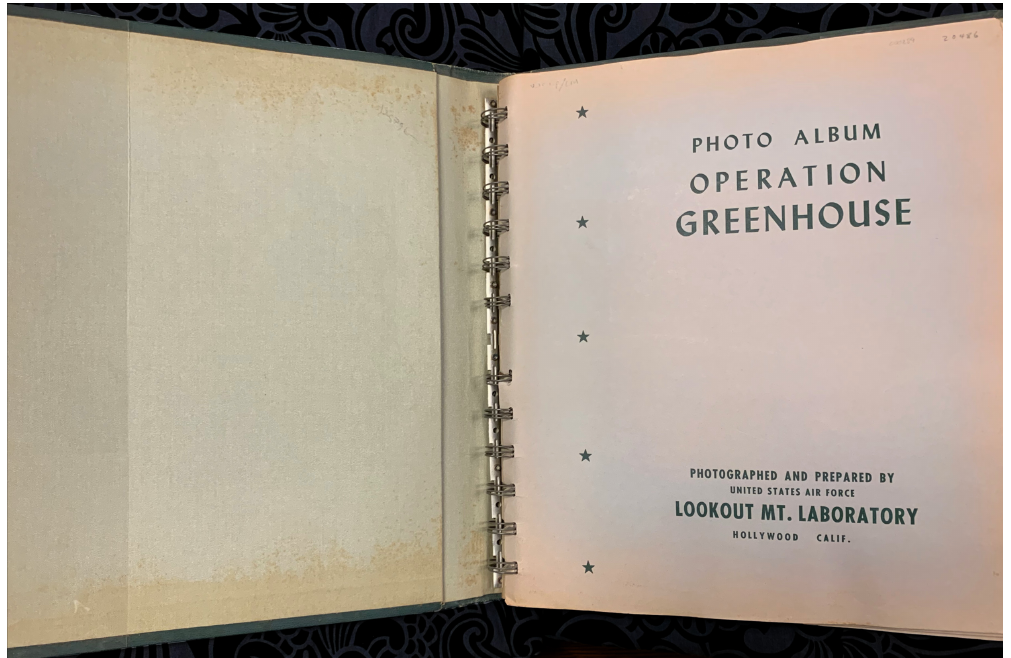
Figure 4: Title page from Operation Greenhouse photo album, 1951. Image courtesy of the Rare Book & Manuscript Library, University of Illinois at